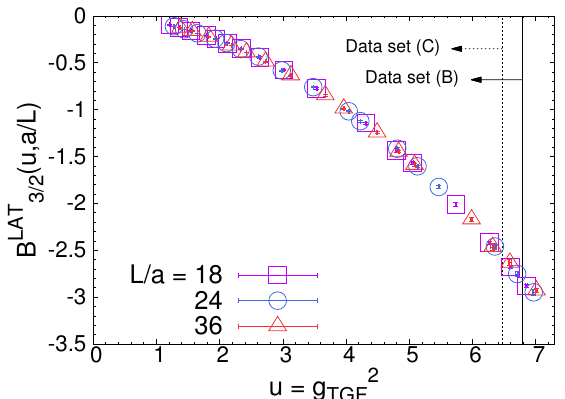
Figure 1 . The discrete beta function on each lattice size.